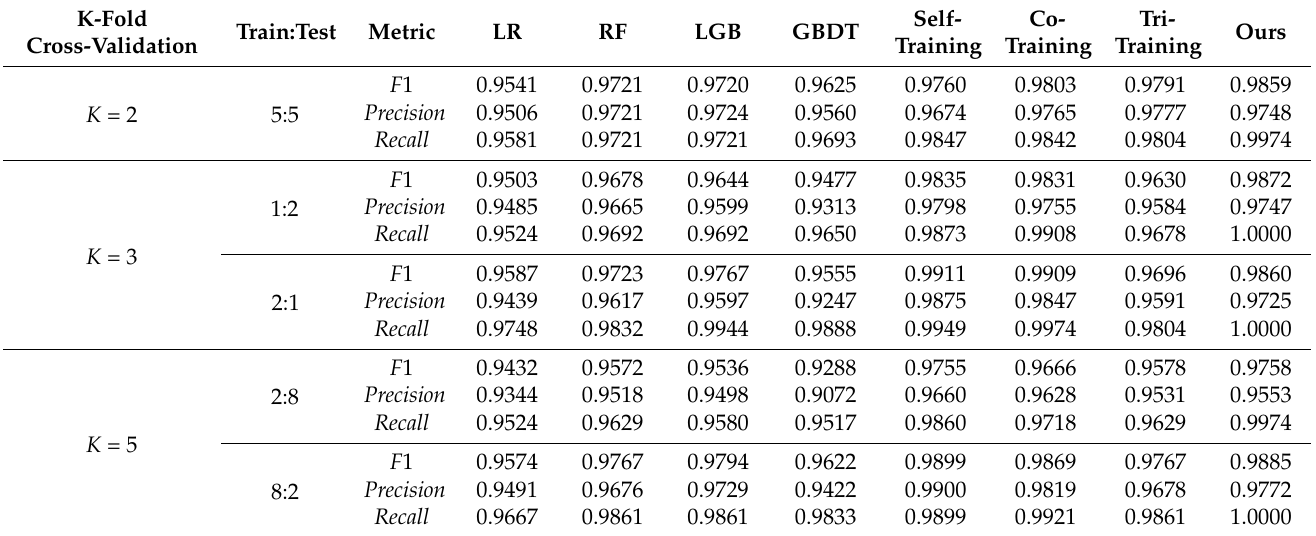
Table 3. Comparison of the results of various models on the Breast Cancer Wisconsin Dataset. K-Fold